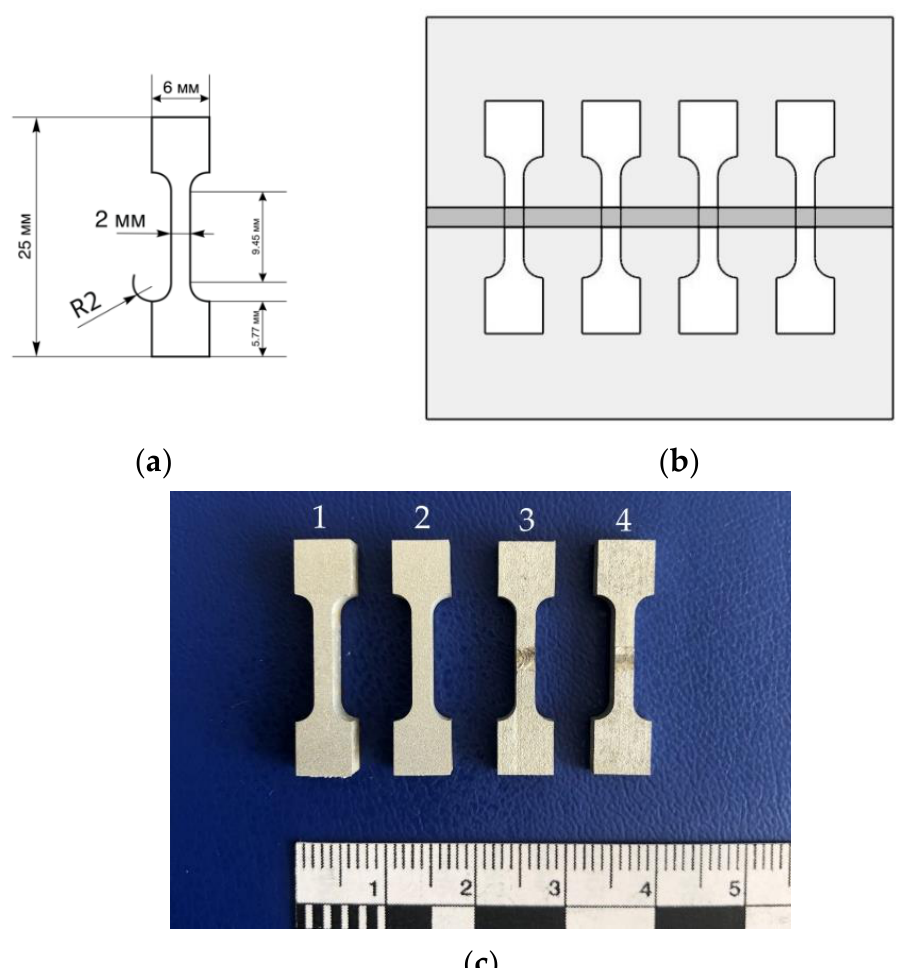
Figure 2. ( a ) Drawing of the sample for tensile tests; ( b ) the scheme of sampling location on the plate with weld; ( c ) the image of samples without (1, 2) and with welding (3, 4) prepared for tensile tests (scale division value is 1 mm).